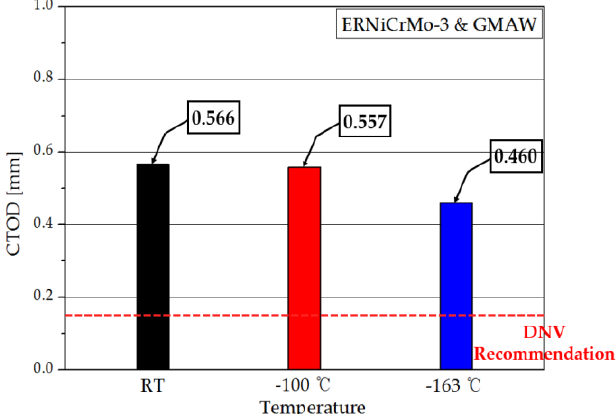
Figure 7. CTOD values of the weldment at various temperatures. Table 6. The chemical composition of other welding consumables [13,17].